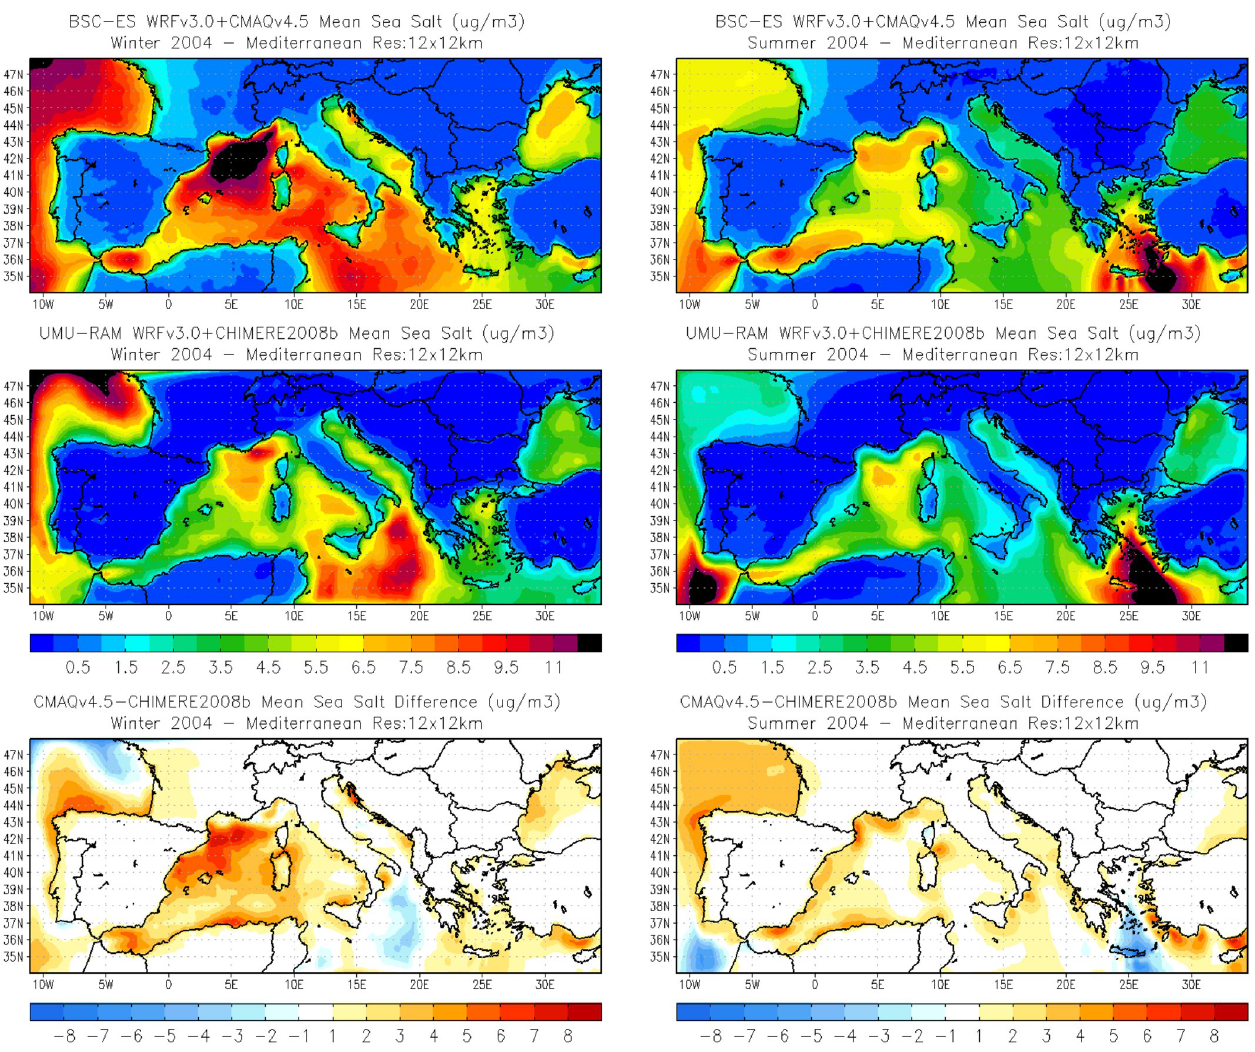
Fig. 4. (Left) modeled winter (DJF) mean SSA concentration (µgm − 3 ) for WRF + CMAQ (top), WRF + CHIMERE (center) and difference between CMAQv4.5-CHIMERE2008b winter mean SSA concentrations (bottom); (right) modeled summer (JJA) mean SSA concentration (µgm − 3 ) for WRF + CMAQ (top), WRF + CHIMERE (center) and difference between CMAQv4.5-CHIMERE2008b summer mean SSA concentrations (bottom).